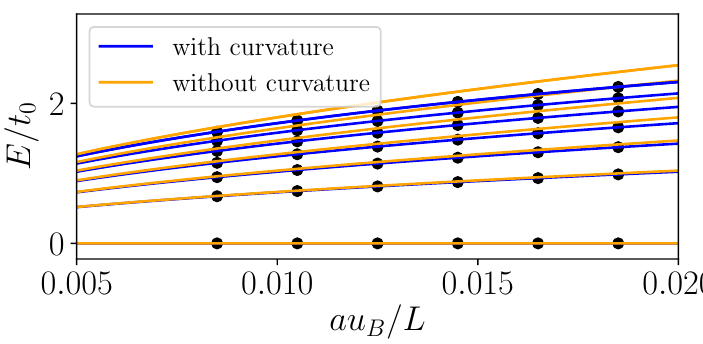
Figure 3: Tight-binding results for the strain profile (32) with TB parameter β = 3. We perform exact diagonalization (ED) of a lattice with 10,000 sites. The circles show the location of the pseudo Landau levels as determined by the peaks in the local density of states (LDOS) as a function of the applied strain au the prediction (1) with (blue curve) and without curvature (orange curve) to the data and see that only the model with curvature accurately fits the